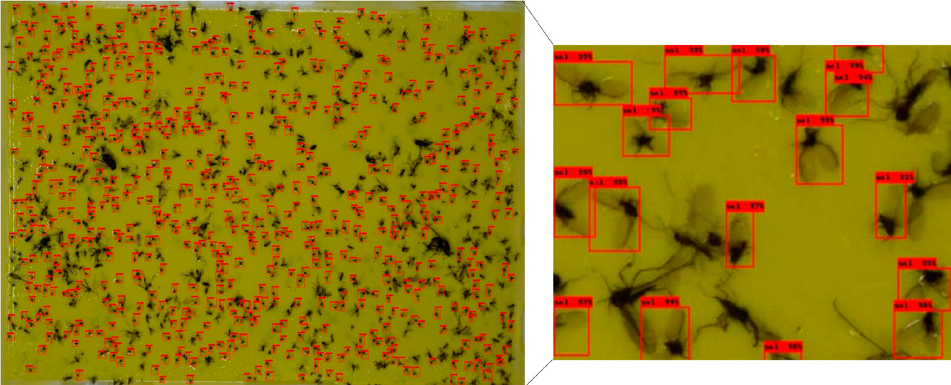
Figure 4. Example of the high amount of M. thunbergianae in sticky traps. The original image has a resolution of 6000 × 4000 pixels, and the size of the ground truth bounding box of M. thunbergianae was 60 × 60 pixels on average. Images adapted from [59].